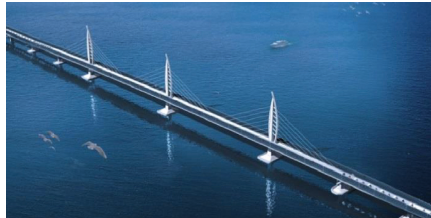
Figure 2: Jianghai Shipping Channel